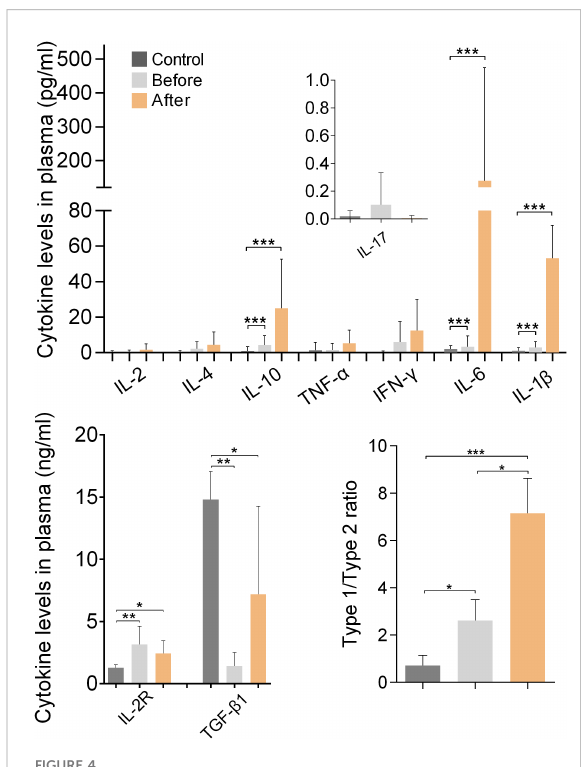
FIGURE 4 Plasma cytokine and sIL-2R levels of marathon runners before and after the race and of control subjects. Cytokine concentrations are shown as mean (SD). The concentration of IL-17 was measured in fg/ml and is shown in pg/ml. Type-1/ type-2 cytokine ratio: [IL-1 b +IL-2+IL-6+IL-17+IFN- g +TNF- a ]:[IL-